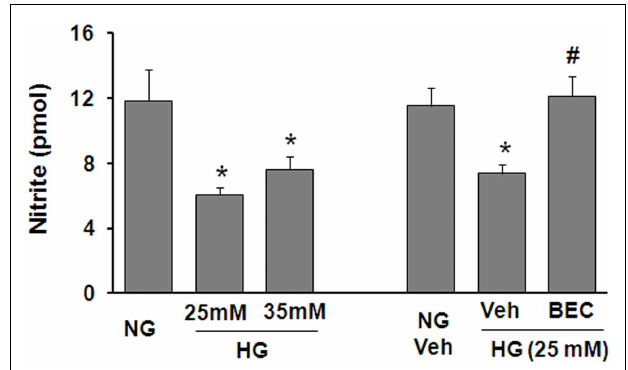
FIGURE 4 | Prevention of high glucose-induced decreases in bioavailable NO levels in retinal endothelial cells by inhibition of arginase. Retinal EC (p5–p9) were incubated in medium (M199 + 0.2%FBS + 50 µ M l-arginine) containing 5.5mM d-glucose (NG), 25mM d-glucose (HG), or 35mM d-glucose with or without 10 µ M BEC or vehicle (Veh, 0.1% saline) for 24h.The nitrite level in the medium was determined by NO analyzer (* p < 0.05 compared with NG, # p < 0.05 vs. Veh, n = 8–16).